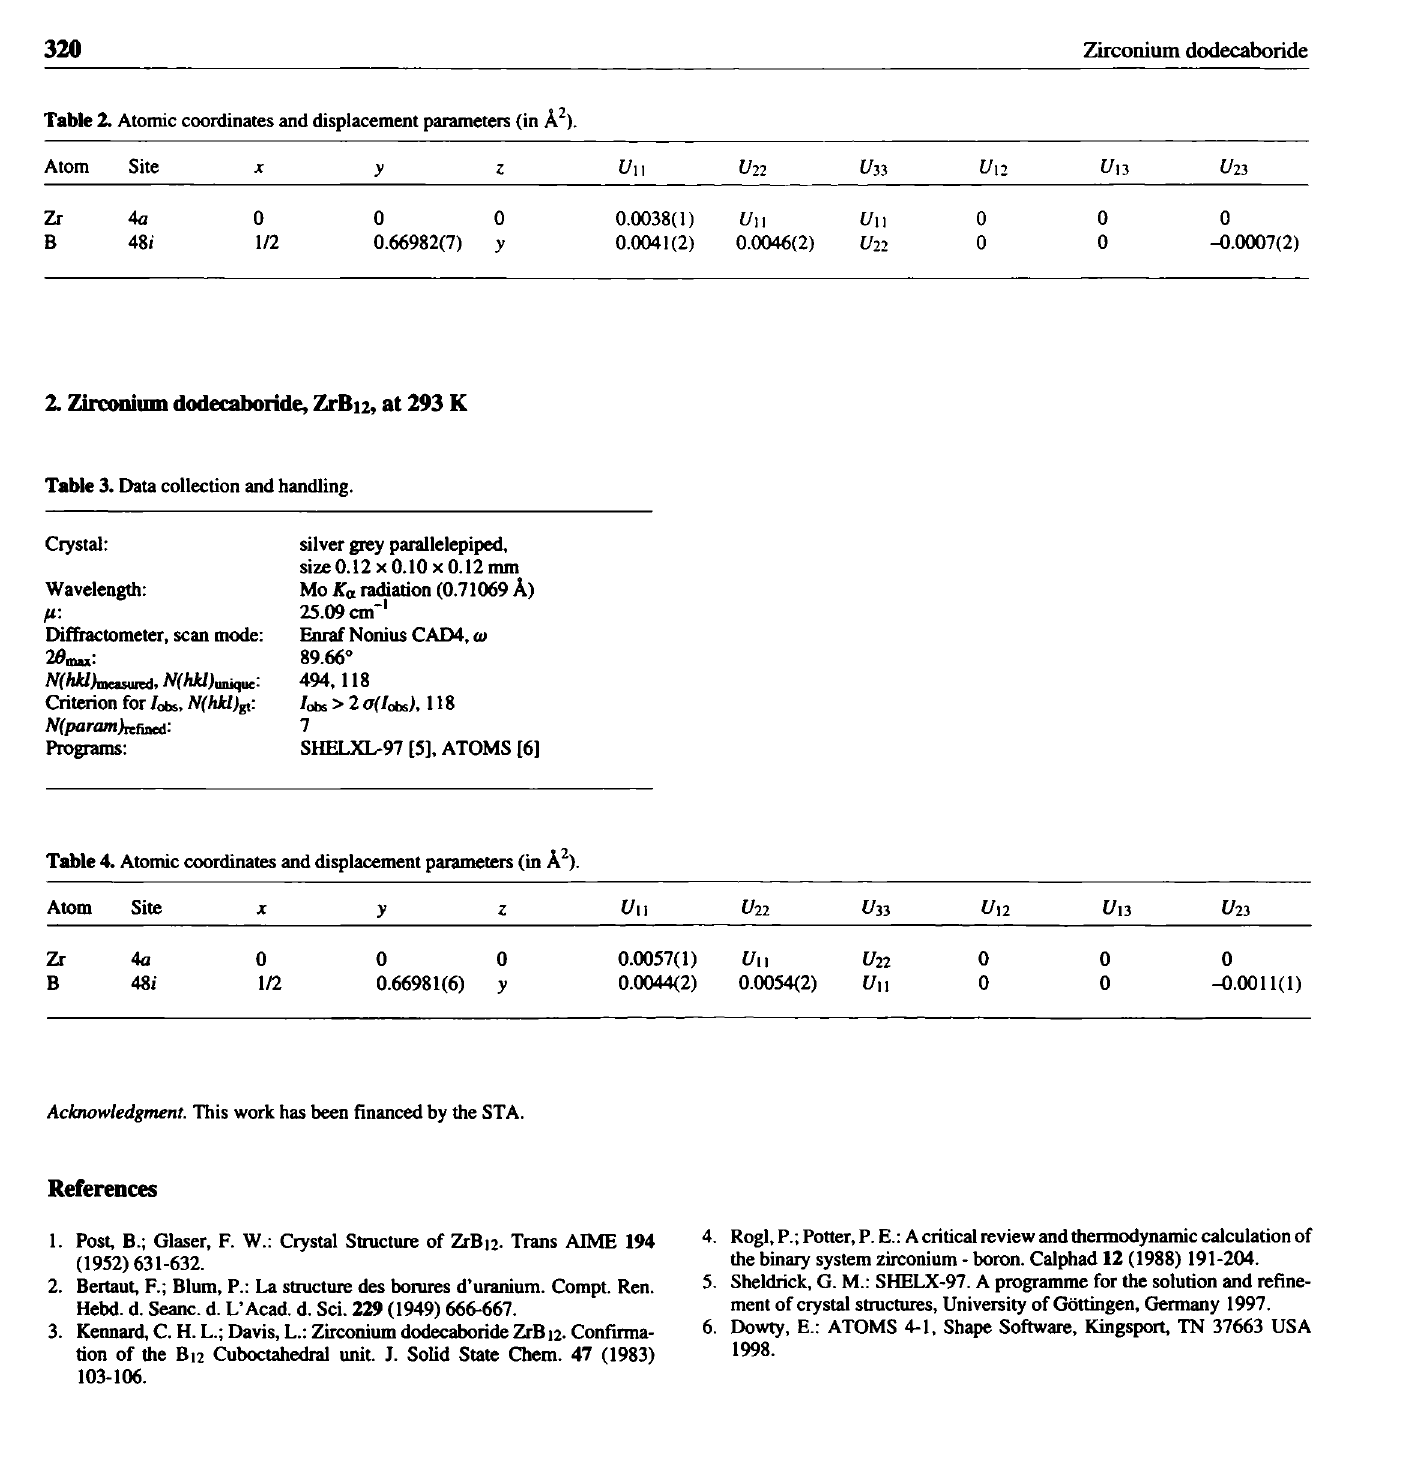
Table 2. Atomic coordinates and displacement parameters (in Â 2 ).